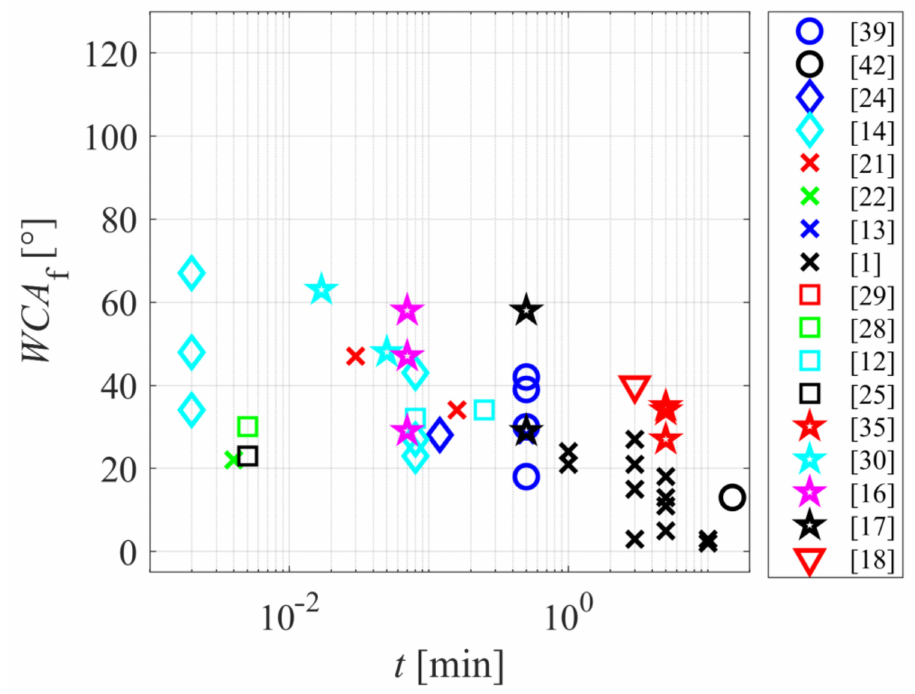
Figure 3. The final water contact angle versus the treatment